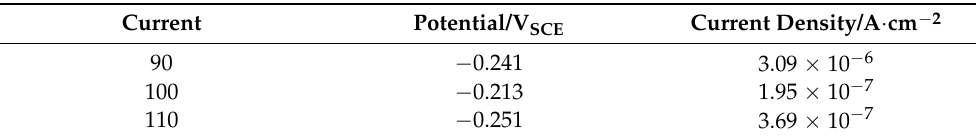
Table 2. Fitting parameters obtained by using CView analysis software to deal with the potentiody- namic polarization curves.